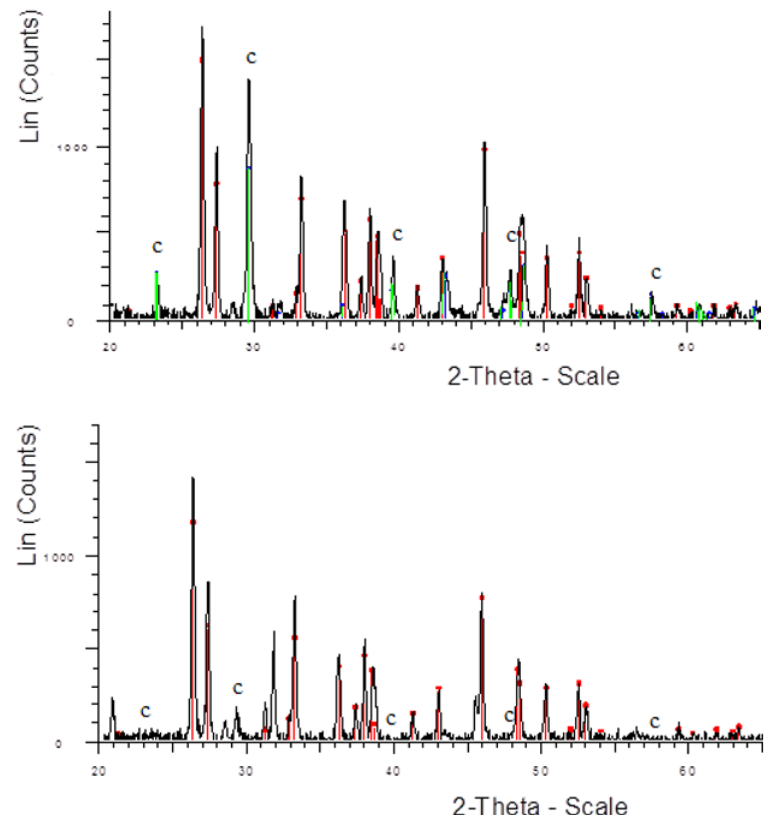
Figure 6. Powder diffraction analysis of CaCO (upper pattern denotes the untreated water, lower one EGD treated water; C- calcite (marked 3 green), aragonite peaks are marked